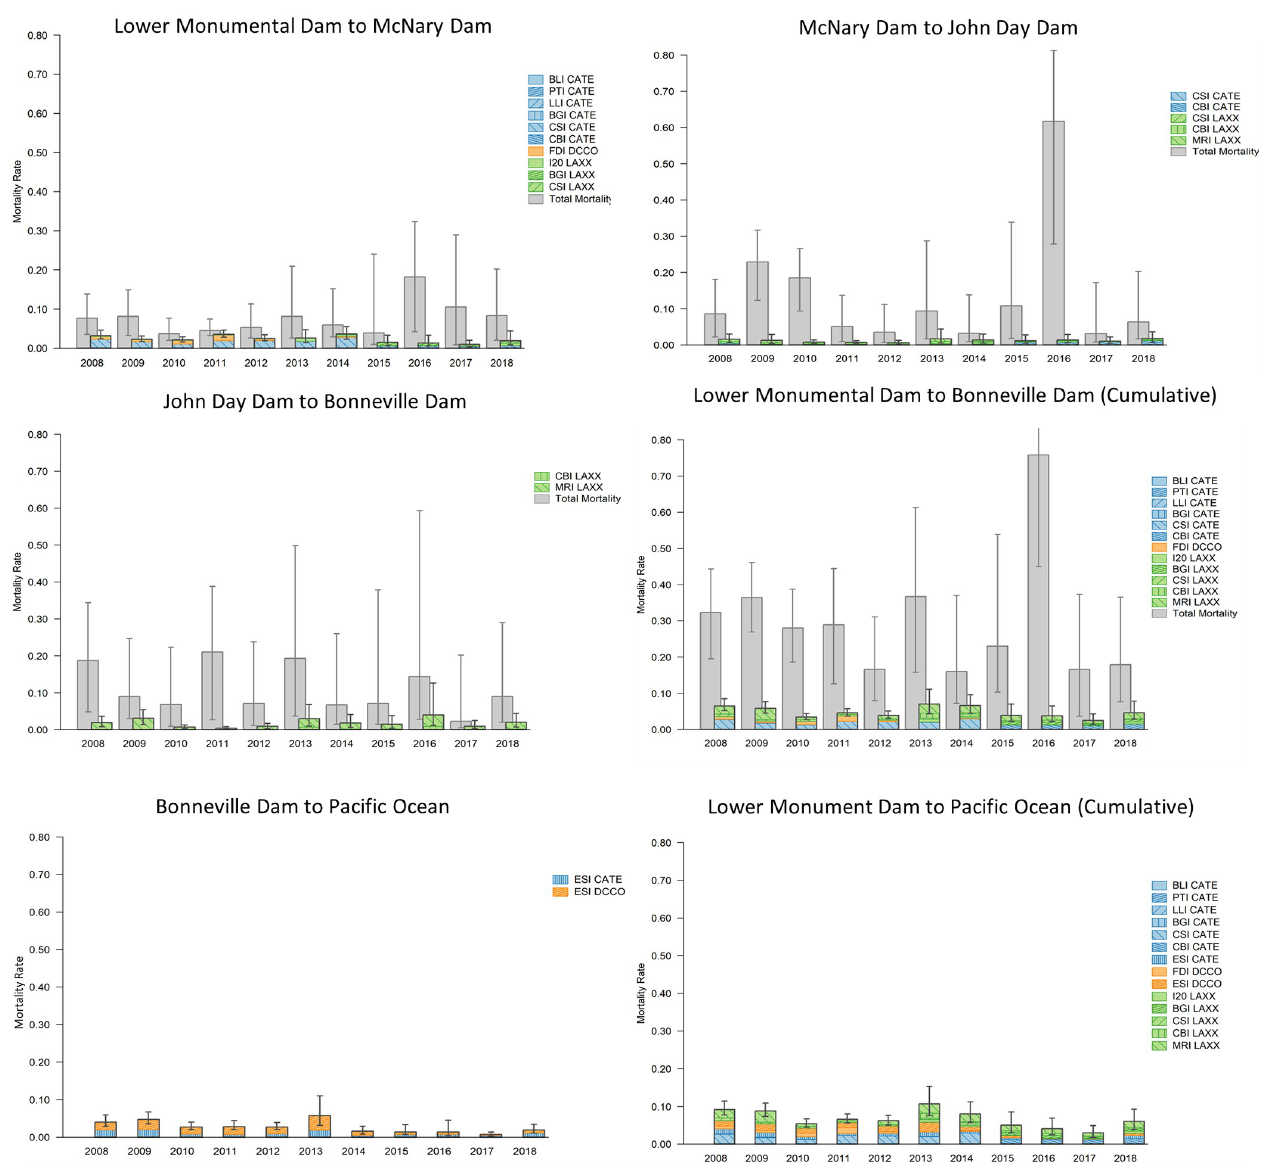
Fig 4. Avian consumption and total mortality of snake river sub-yearling Chinook salmon. Estimated annual colony-specific, reach-specific, and cumulative avian consumption probabilities (colored bars) and total mortality (grey bars) of Snake River sub-yearling Chinook salmon smolts during passage from Lower Monumental Dam on the Snake River to the Pacific Ocean. Piscivorous waterbird colony locations include Banks Lake Island (BLI), Potholes Reservoir (PTI), Lenore Lake Island (LLI), Island 20 (I20), Foundation Island (FDI), Badger Island (BGI), Crescent Island (CSI), central Blalock Islands (CBI), Miller Rocks Island (MRI), and East Sand Island (ESI). Bird species include Caspian terns (CATE), double-crested cormorants (DCCO), and California and ring-billed gulls (LAXX). Error bars represent 95% credible intervals for total mortality and avian